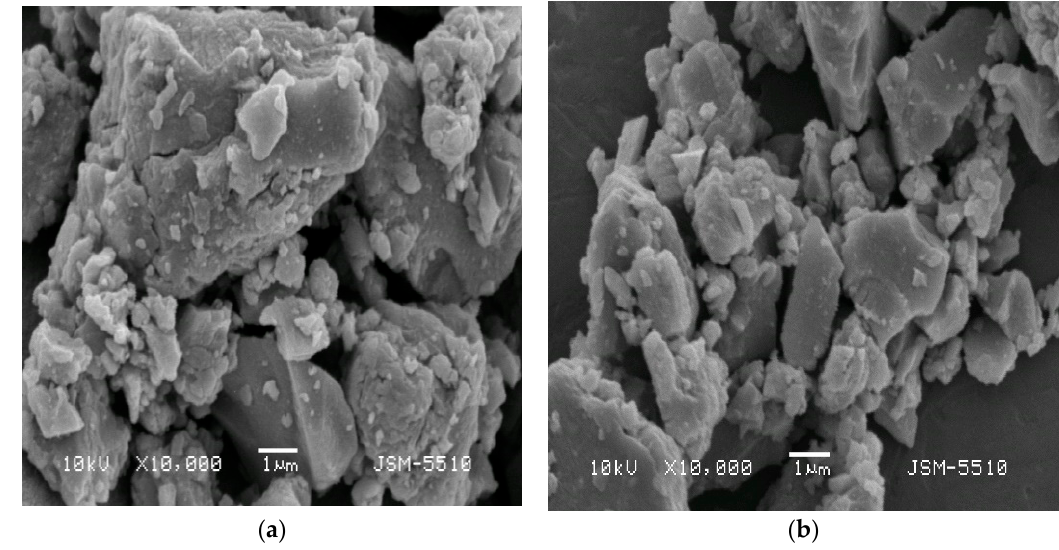
Figure 10. SEM images of calcinated aged TiO 2 aerogel in dependence of precursor type (TIP ( a ), TBOT ( b )).